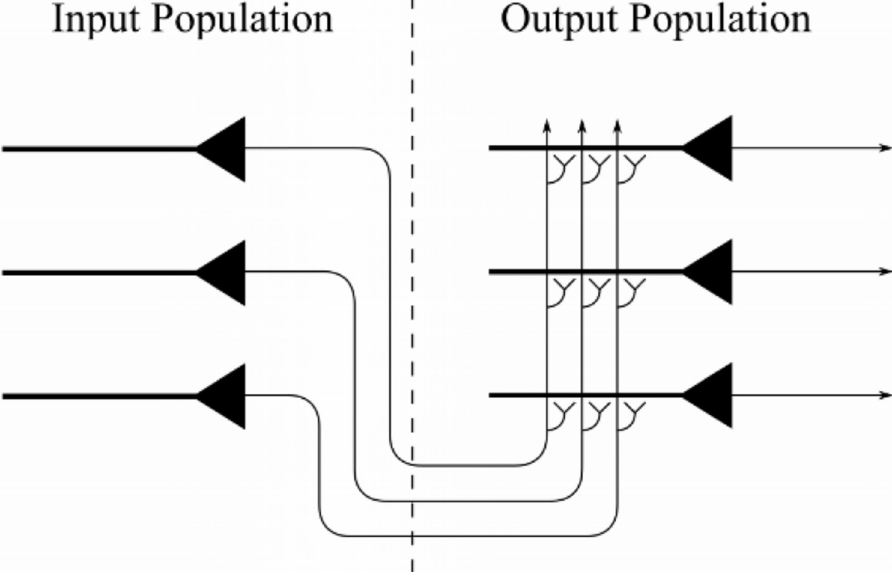
Fig 1. Architecture of the neural network model. The competitive output layer on the right receives afferent synaptic connections from neurons in the input layer on the left. A trace learning rule is used to modify the strengths of the feedforward synaptic connections from the input layer to the output layer during